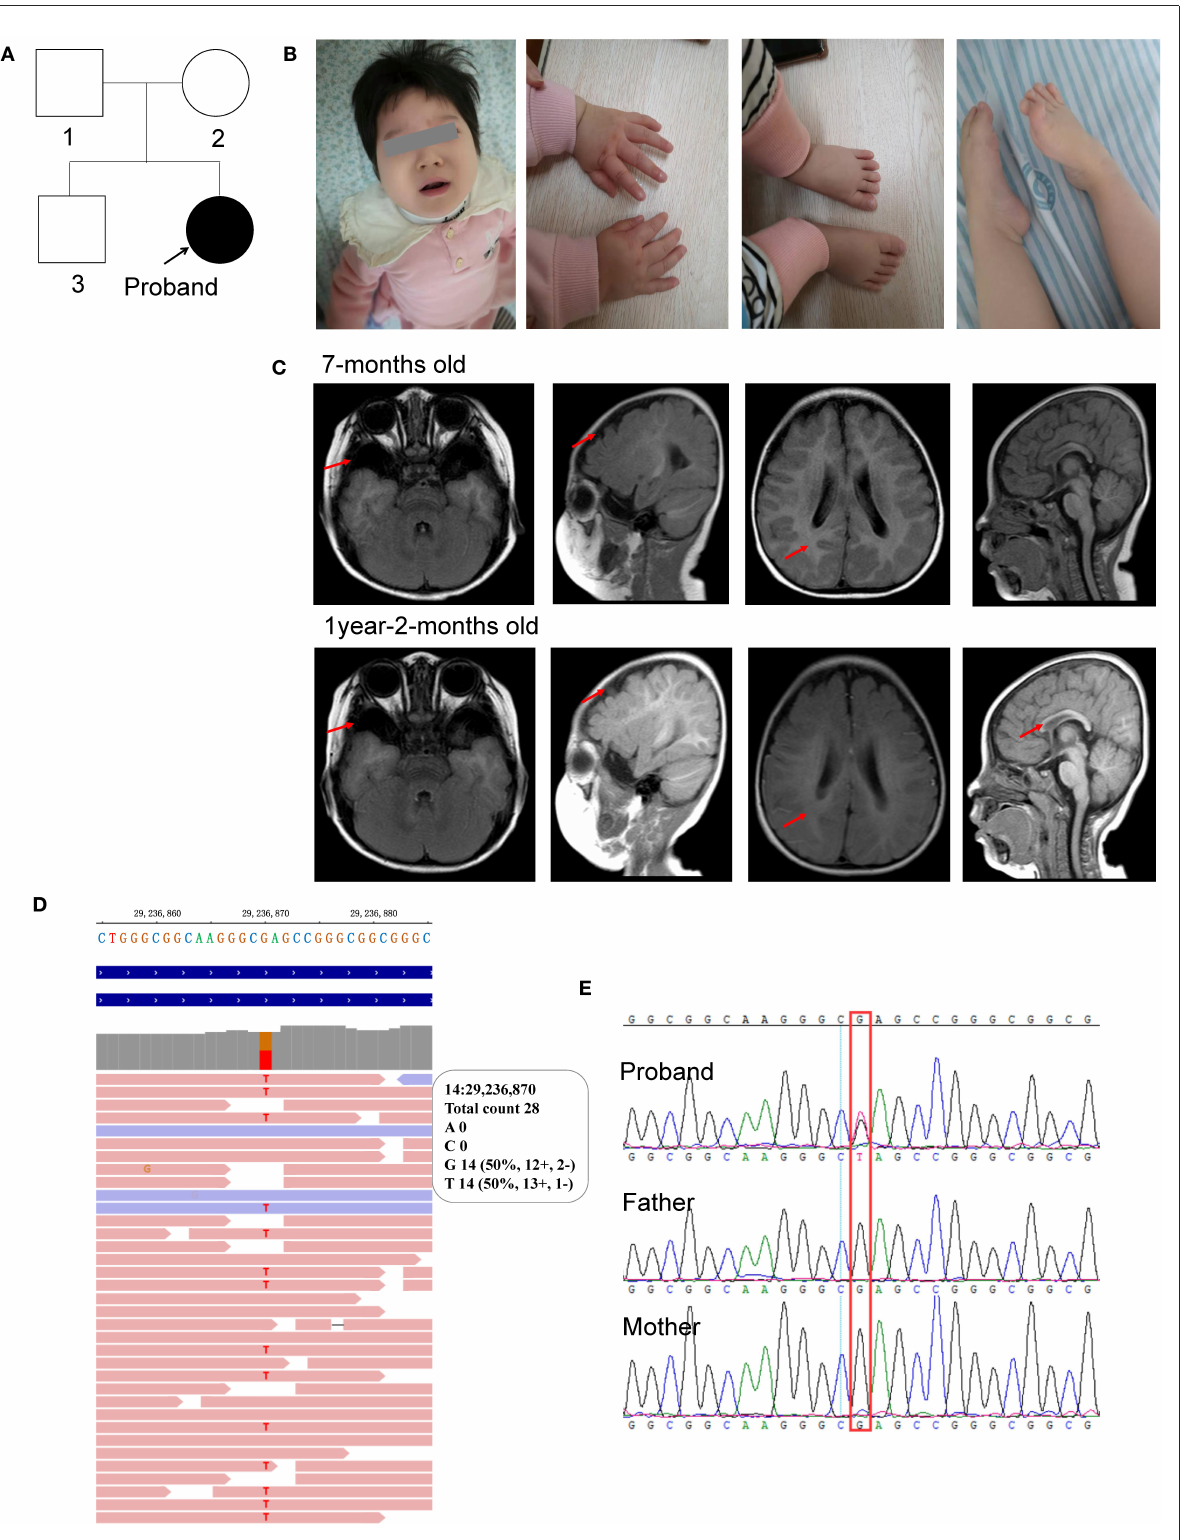
FIGURE1 Characterization of the clinical features of the proband. (A) Pedigree of the proband; (B) photos of the facial, hands, and foot; (C) brain MRI scan taken at 7-months old and 1-year-2-months old; (D) WES identified c.385G > T in the proband; (E) sanger sequencing. The red arrow represents the abnormal